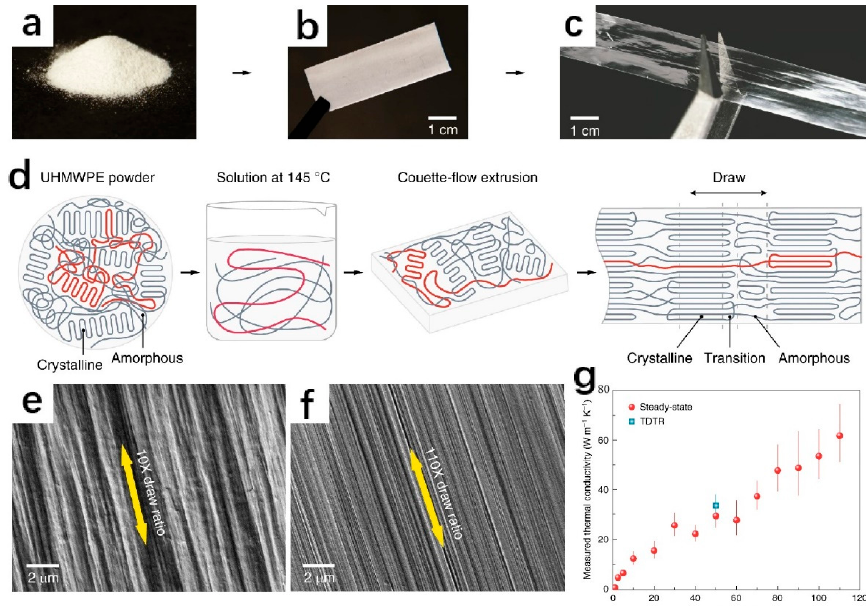
Figure 8. Optical photographs. ( a ) UHMWPE powder; ( b ) opaque extruded film; ( c ) transparent drawn film; ( d ) schematic diagram of the preparation process of a high-thermal-conductivity polymer film. SEM images of films with different draw ratios ( e ) with a draw ratio of 10; ( f ) with a draw ratio of 110; ( g ) thermal conductivity of polymer films at different draw ratios. The red dots are the steady-state experimental test results, and the blue square is the average of 20 transient thermal conductivities (reproduced with permission from Reference [62] , Copyright 2019, Xu et al.). Table 2. Summary of FFF thermally conductive fillers.